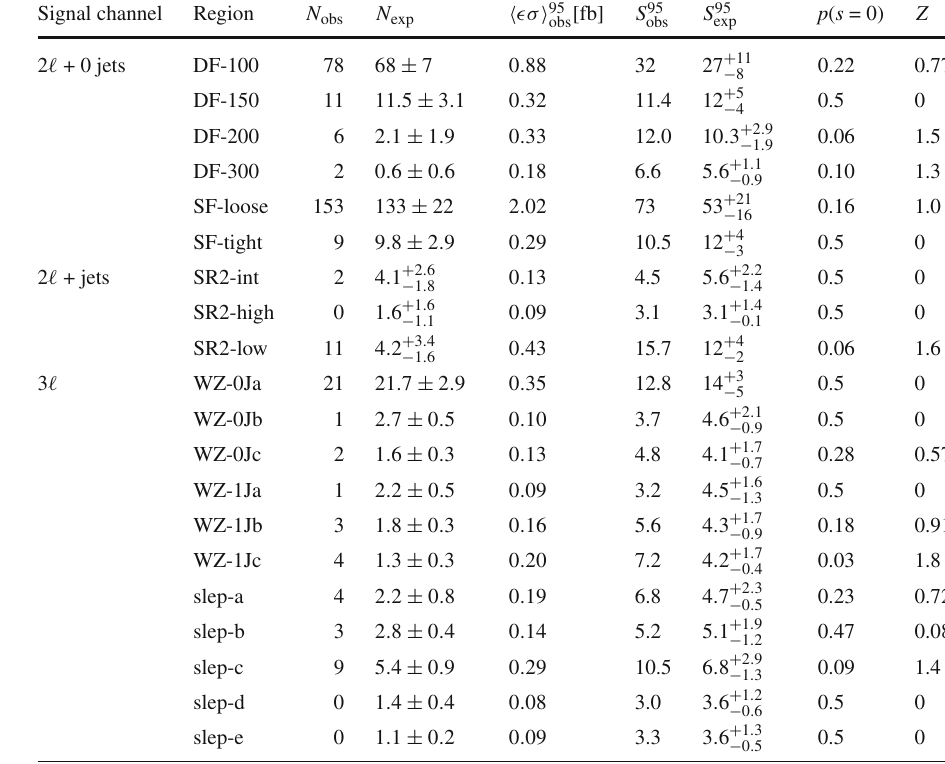
Table 15 Summary of